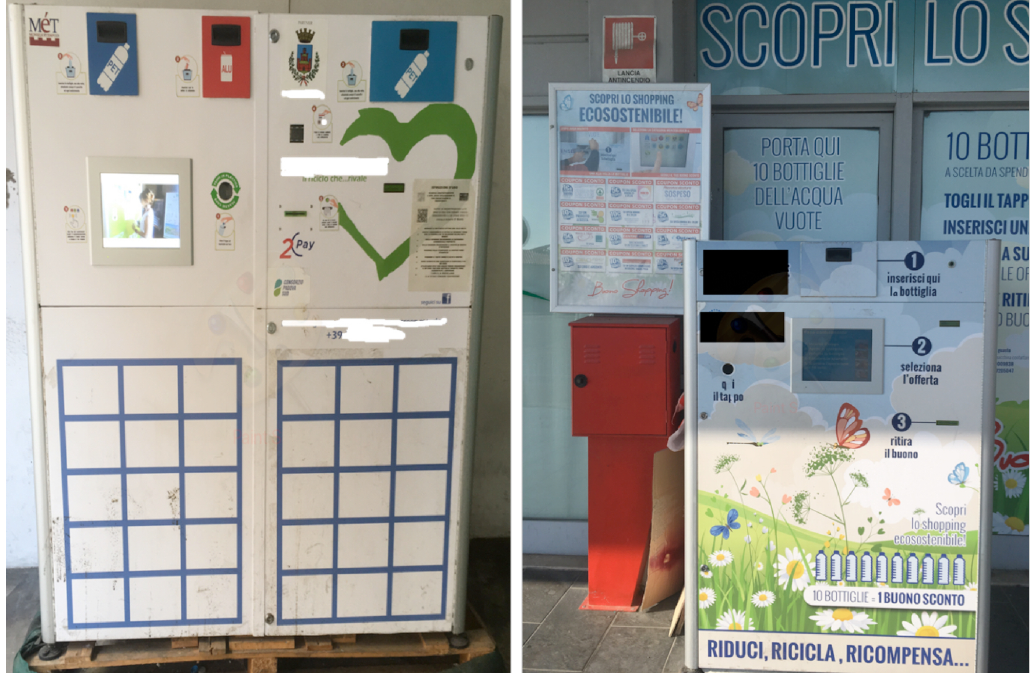
Figure 1. The two RVMs considered for this research: on the left the one settled in the city centre, on the right the one positioned side to the entrance of a shopping mall. Source: Photo by the